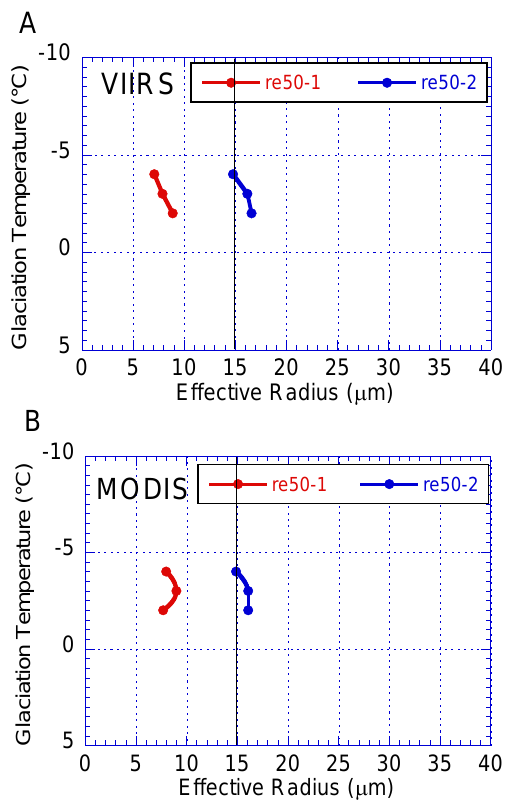
Fig. 9. Same as Fig. 5, but for the polluted area over the La Trobe Valley, Australia, on 29 April 2012. Line 1 (red) shows the polluted clouds with small drops that reside in rectangle 1 of Fig. 6; line 2 (blue) shows the background clouds with the larger drops that reside in rectangle 2 of Fig.